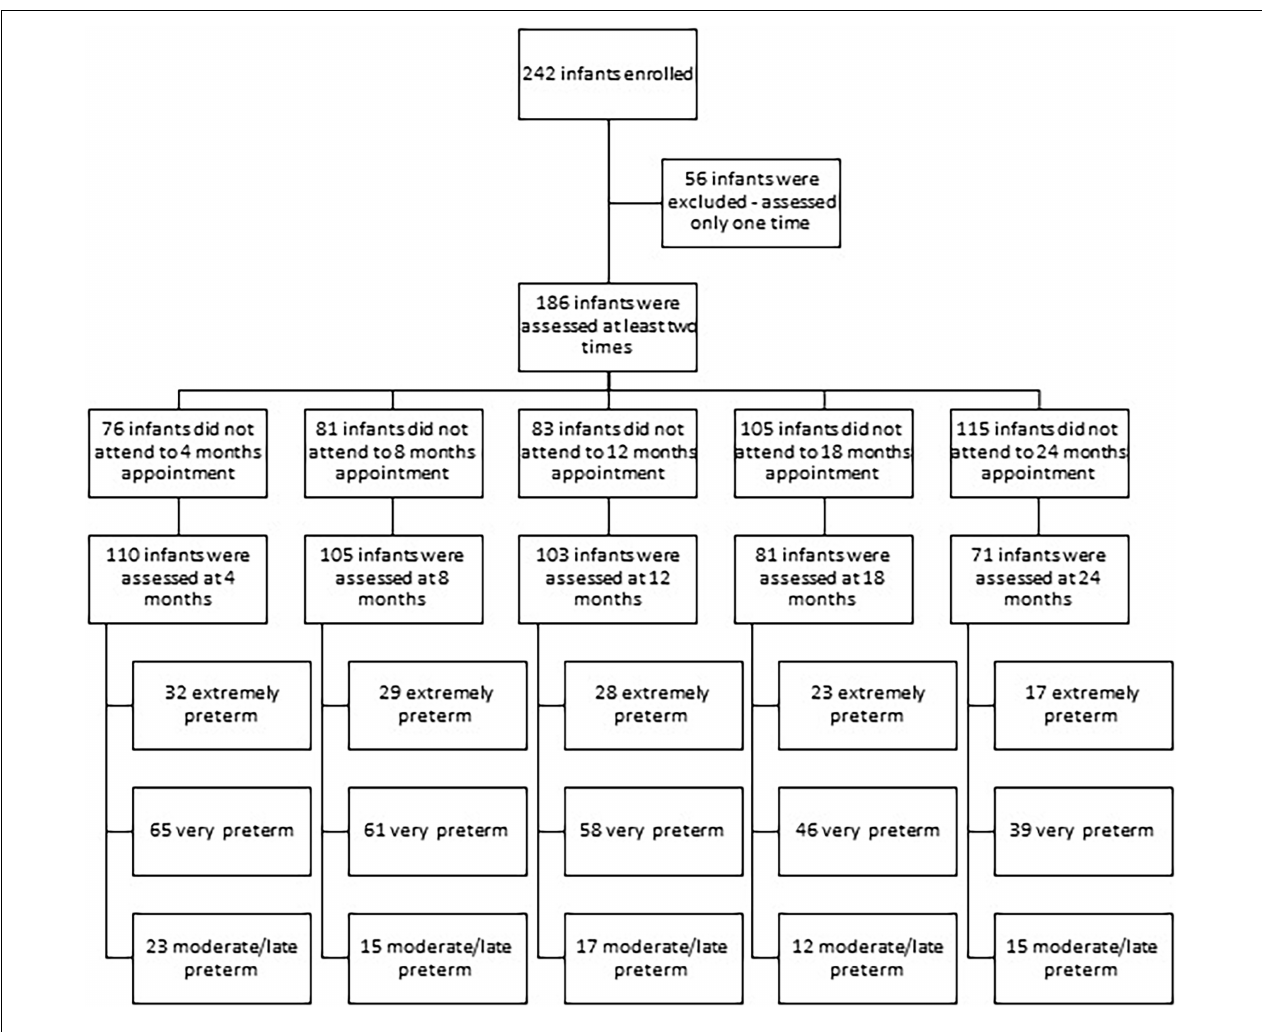
FIGURE 1 | Flow chart of infants enrolled in the